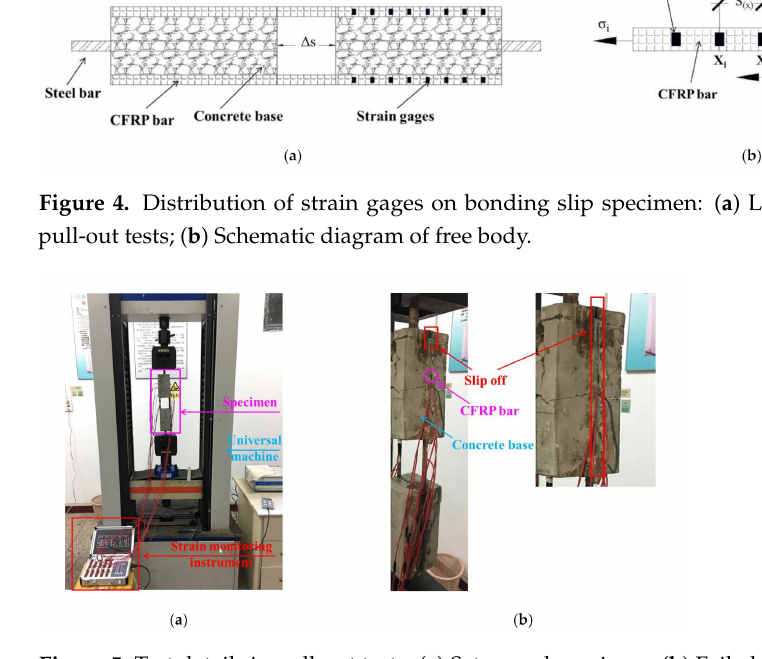
Figure 5. Test details in pull-out tests: ( a ) Setup and specimen; ( b ) Failed specimen. Table 4. Results from pull-out